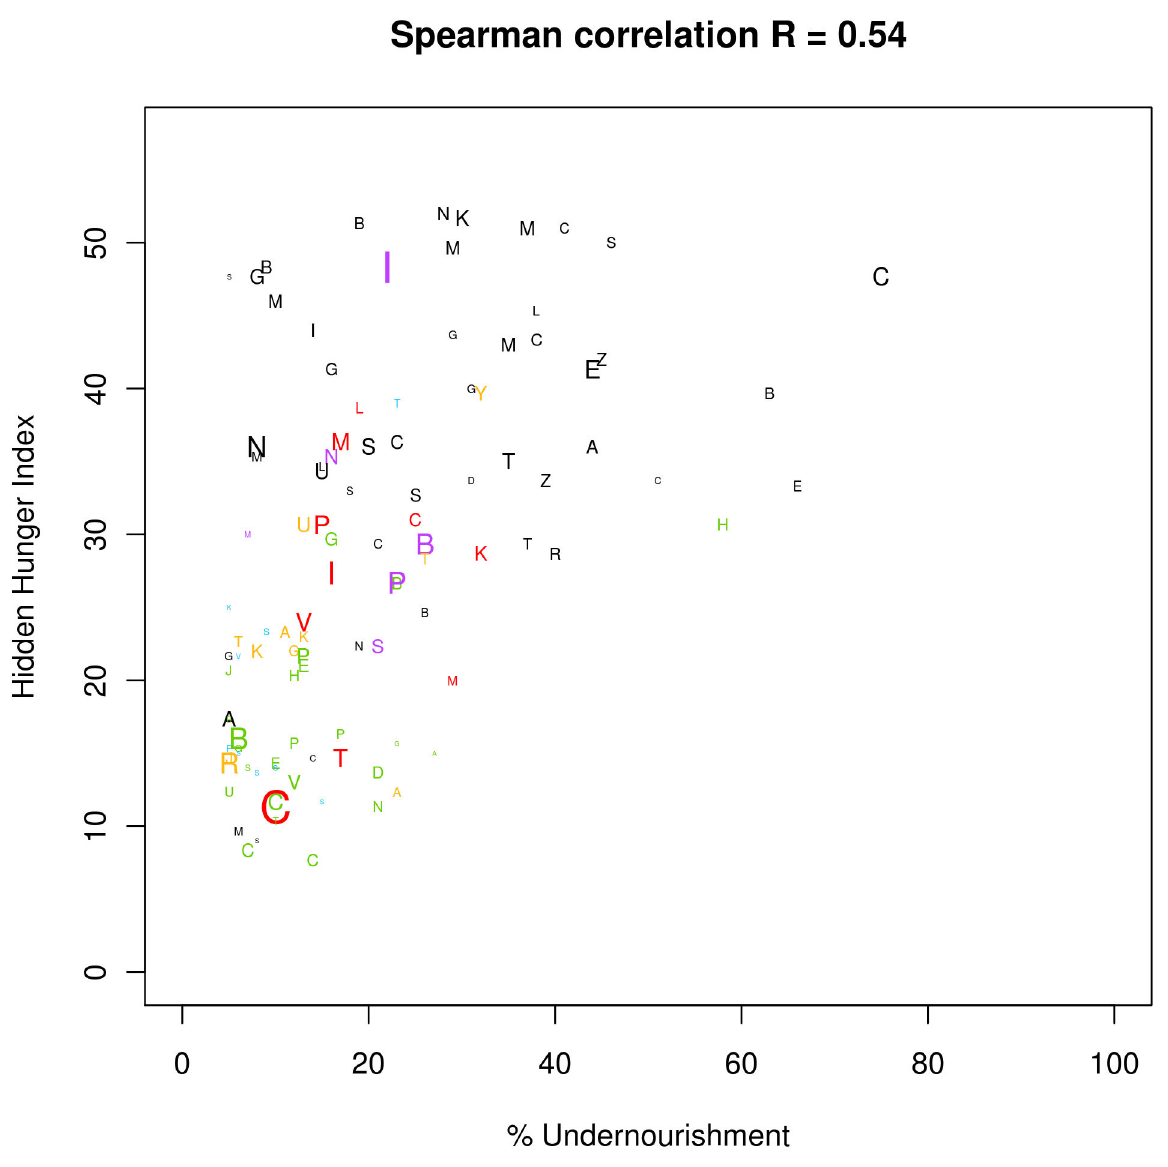
Figure 4. The association between hidden hunger index based on the prevalence estimates (HHI-PD) and the proportion of the population with inadequate dietary energy. The alphabet characters symbolize the first initial of each country; the font sizes are proportional to the population size. Font color represents different regions, such that black represents Africa; red, East Asia; yellow, West Central Asia; green, Central and South America; turquoise, the Pacific Islands, and the Caribbean; purple, South Asia; and blue, Europe, North America, Australia, and New